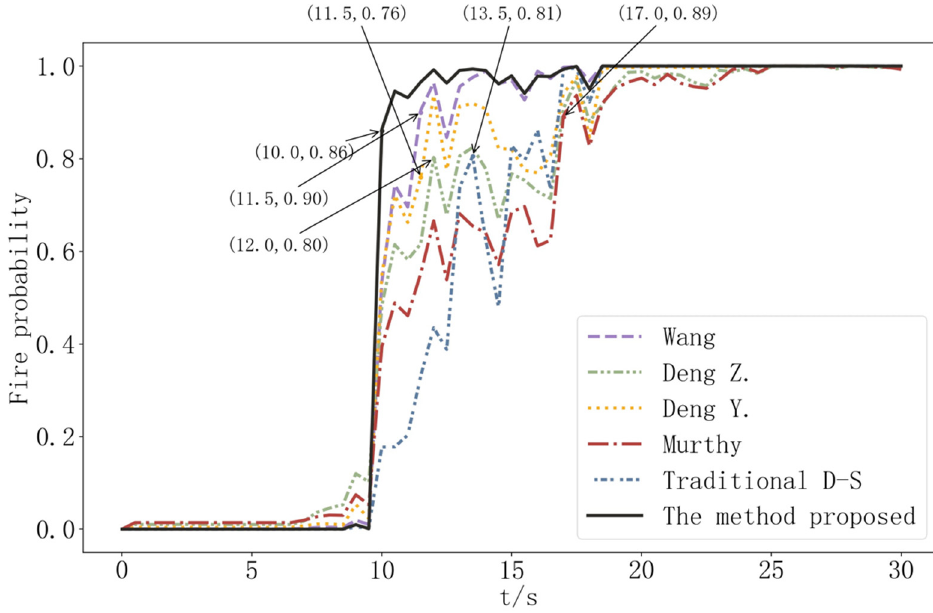
Figure 11. Fire occurrence probability comparison in smoldering fire scene.